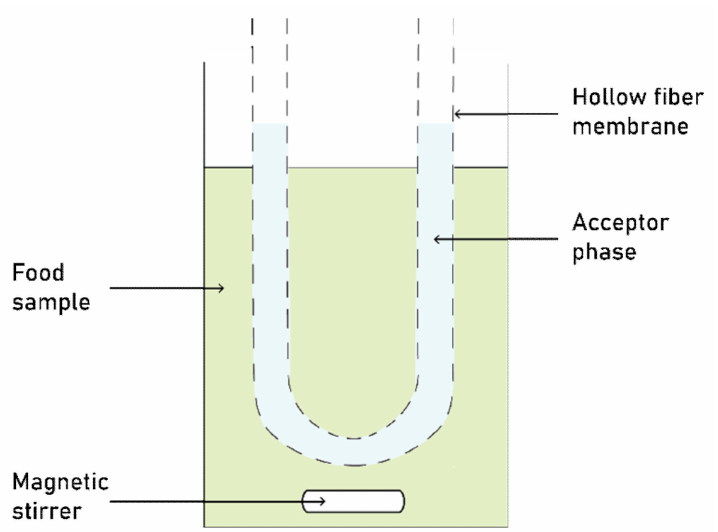
Figure 3. Two-phase hollow fiber-liquid microextraction setup. Adapted from Esrafili et al. [93]. Cui et al. [63] reported a phenolic extraction from green tea by heating and stirring acid, and citric acid as the HBDs. The ChCl:ethylene glycol (1:2) was the best